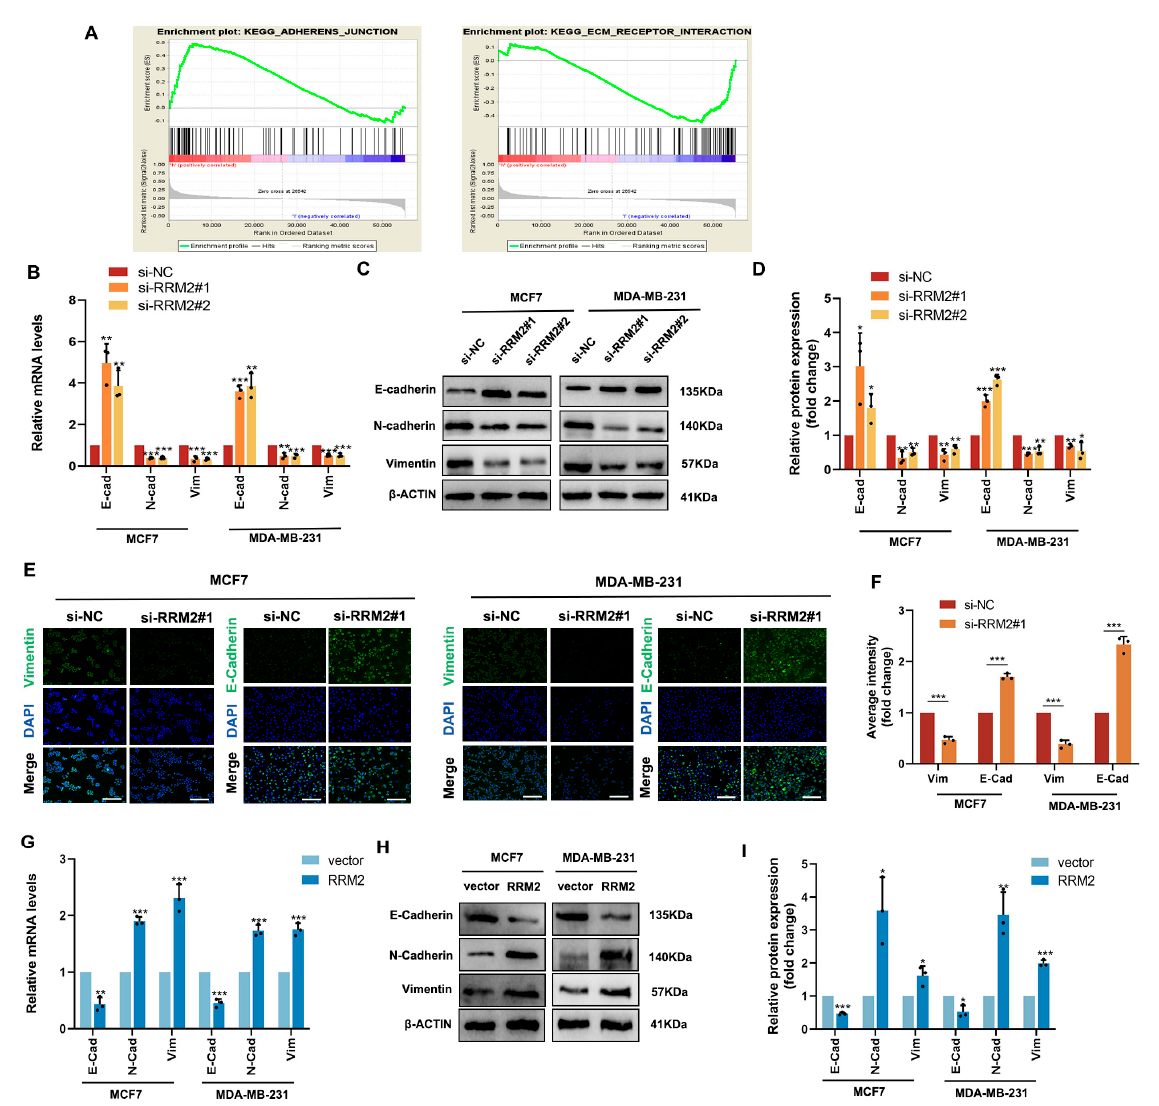
Figure 7. RRM2 regulates the EMT program of BRCA cells in vitro. The GSEA results show the RRM2 enrichment pathway ( A ). The levels of E-cadherin, N-cadherin, and vimentin expression were identified with RT-qPCR ( B ) and Western blotting ( C , D ) after being transfected with si-NC or si-RNAs in MCF7 and MDA-MB-231. The expression and distribution of E-cadherin and vimentin were identified by immunofluorescence ( E , F ). Scale bars: 50 μ m. MCF7 and MDA-MB-231 were transduced with a corresponding control vector and RRM2 plasmids. The expression levels of E- cadherin, N-cadherin, and vimentin were identified with RT-qPCR ( G ) and Western blot ( H , I ). * p < 0.05, ** p < 0.01, *** p < 0.001. Data represent the means ± SD of three independent experiments.